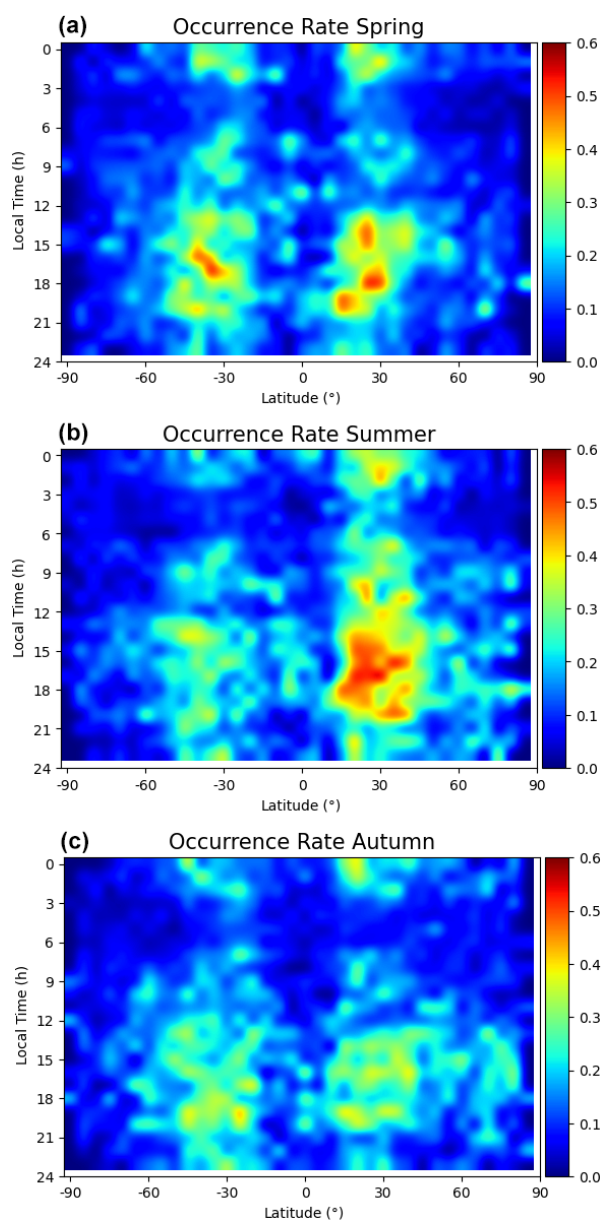
Figure 6. The distribution of E s occurrence rate for three different seasons in 1h × 5 ◦ local time/geographic latitude grid, (a–c) are the results of spring, summer, and autumn,